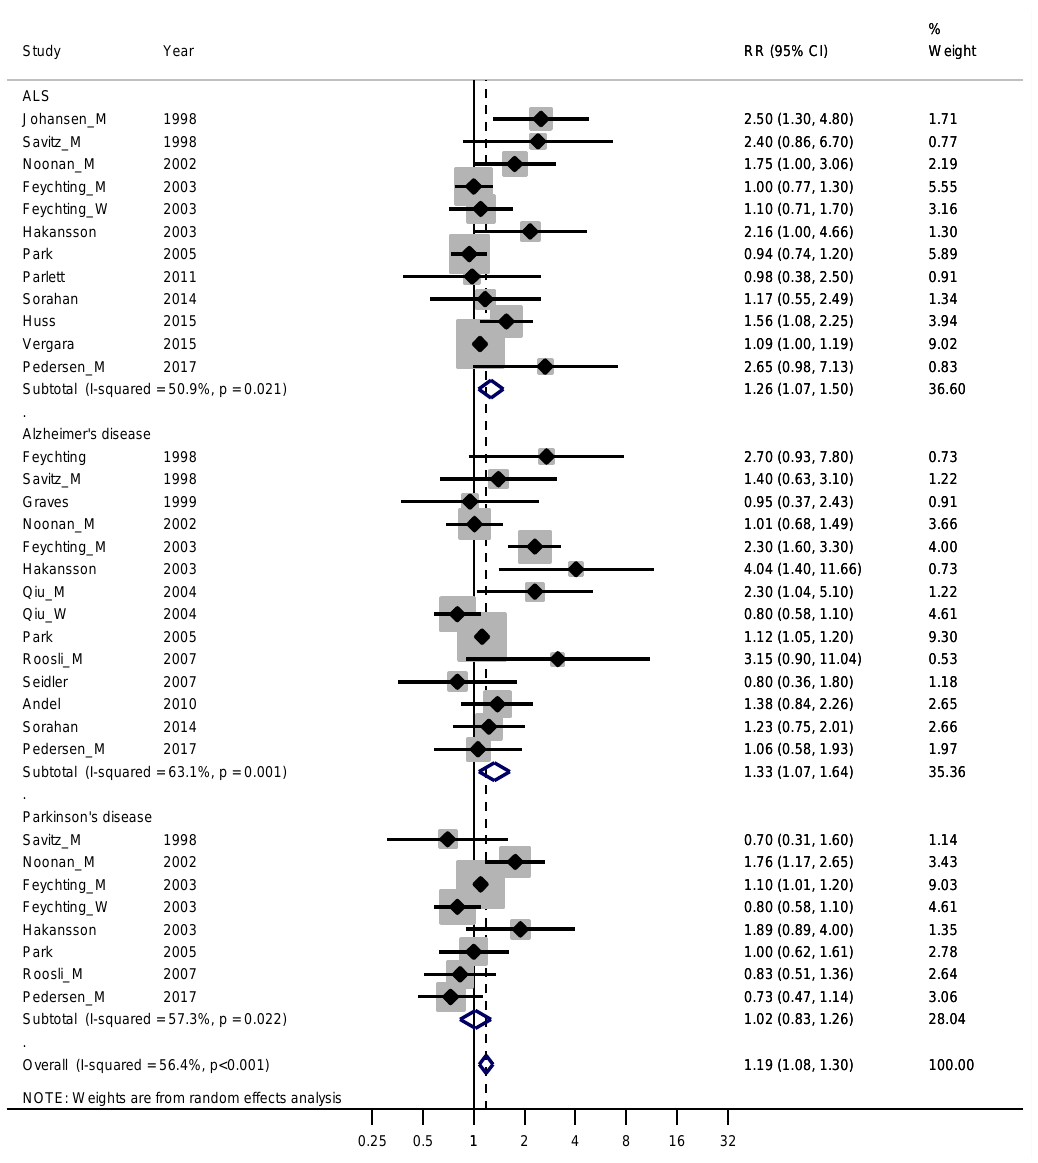
Figure 1. Forest plot for studies assessing the association between amyotrophic lateral sclerosis (ALS), Alzheimer’s disease and Parkinson’s disease and occupational exposure to electromagnetic fields (EMFs). Results for men only are indicated by M, for women by W; otherwise the results concern both sexes. Random effect models were used, with stratification by diagnosis. Heterogeneity was tested by the I 2 statistic ( I -squared), with p < 0.05 indicating rejection of homogeneity. CI = confidence interval; RR = relative risk.